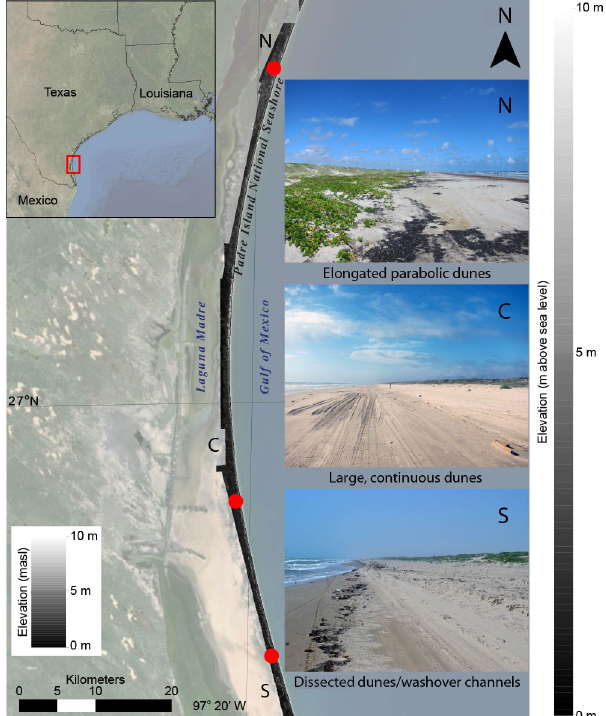
Figure 1. Location map and DEM of the study area at Padre Is- land National Seashore (PAIS), Texas, United States. Elevations for the DEM are reported as meters above sea level (ma.s.l.). Approx- imate locations of field images (red dots) from the northern (N), central (C), and southern (S) regions of the island showing along- shore differences in beach–dune morphology. Note that views are facing south for the central and southern locations, and the northern location view is to the north. Images taken in October